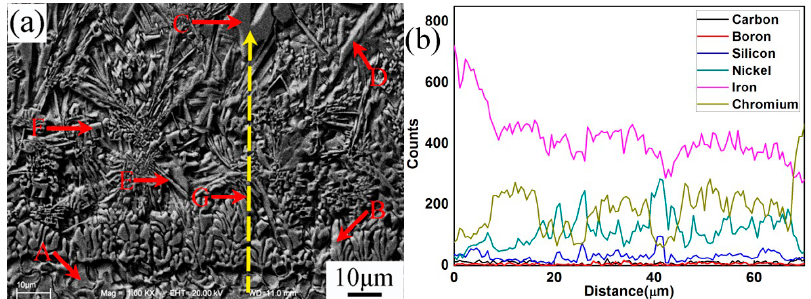
Figure 3. SEM and EDS of interfacial zone of specimen No.1. ( a ) Microstructures of the coating and substrate for specimen No.1 (SEM); ( b ) EDS of interfacial zone of specimen No.1 Table 4. EDS results of different points in Figure 3a (at %).